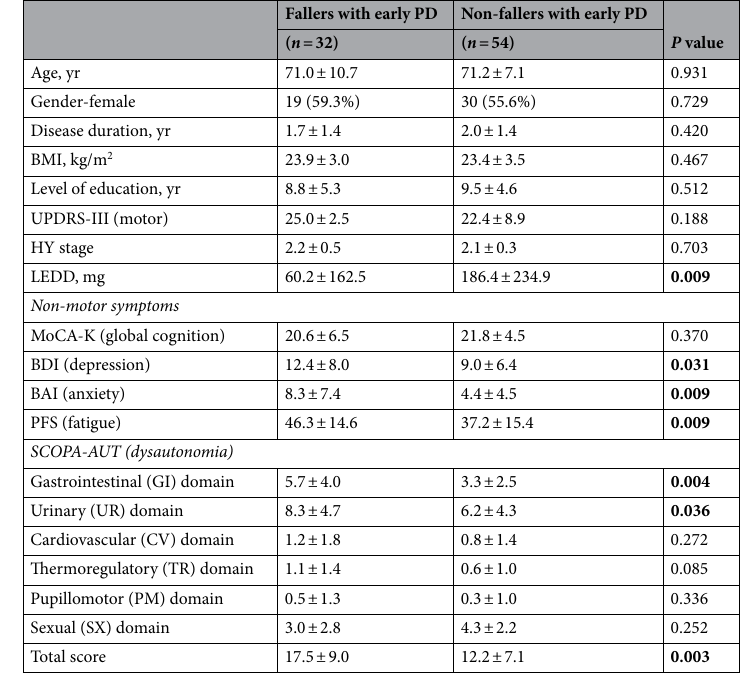
Table 1. Demographics and clinical features between fallers and non-fallers with early Parkinson’s disease (PD). Data are n (%) or mean ± S.D. values. PD Parkinson’s disease, BMI body-mass index, UPDRS-III Unified Parkinson’s disease rating scale–part 3, HY Hoehn and Yahr, LEDD levodopa equivalent daily dose, MoCA-K Korean version of Montreal Cognitive Assessment, BDI Beck depression inventory, BAI Beck anxiety inventory, PFS Parkinson’s disease fatigue scale, SCOPA-AUT Scales for Outcomes in Parkinson’s Disease–Autonomic dysfunction, GI gastrointestinal, UR urinary, C cardiovascular, TR thermoregulatory, PM pupillomotor, SX Sexual. Boldface indicates P <